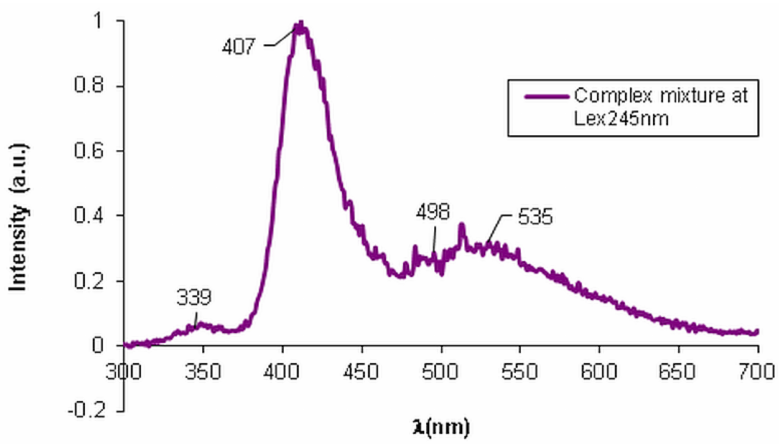
Figure 4. Fluorescence spectra of the complex mixture—HA, MEL, MZ, and